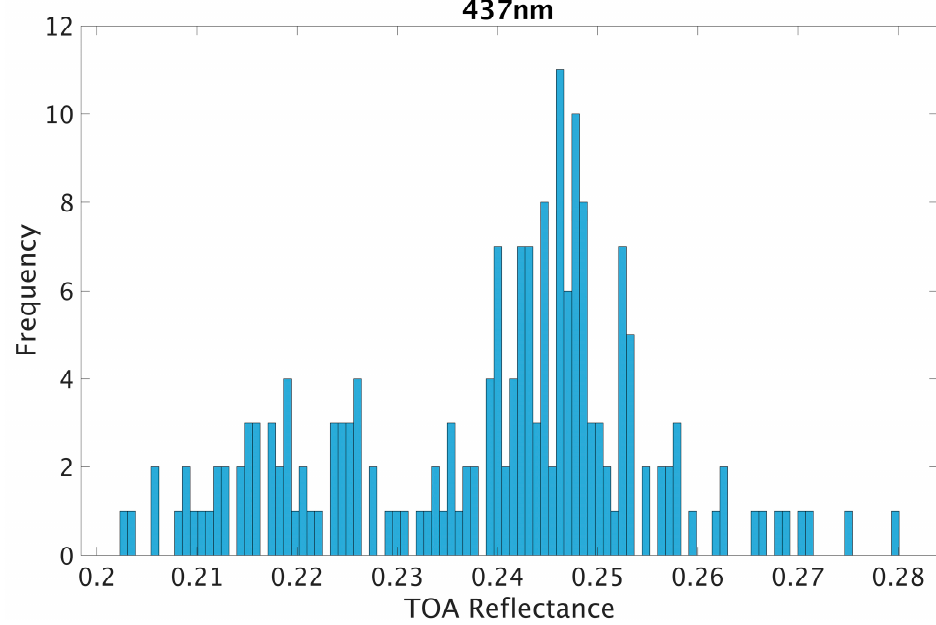
Figure 13. Histogram of TOA reflectance of the Cluster 13 Hyperion images at 437 nm.